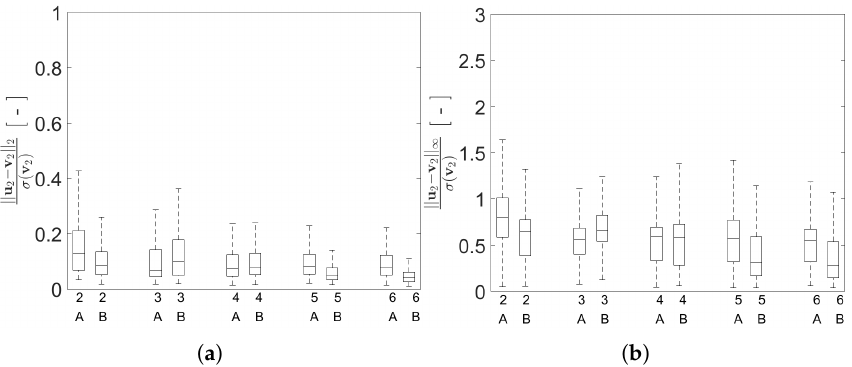
Figure 18. Two-storey shear building, effect of P on the statistics of the reconstruction errors relevant to the floor displacement v 2 , represented through box plots, for data taken from the test set and both structural configurations A and B: ( a ) standardized L 2 norm; ( b ) standardized L ∞